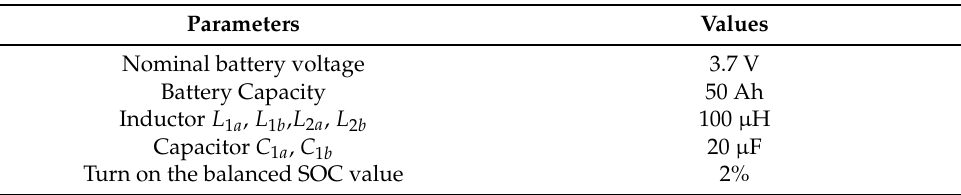
Table 3. Model parameter